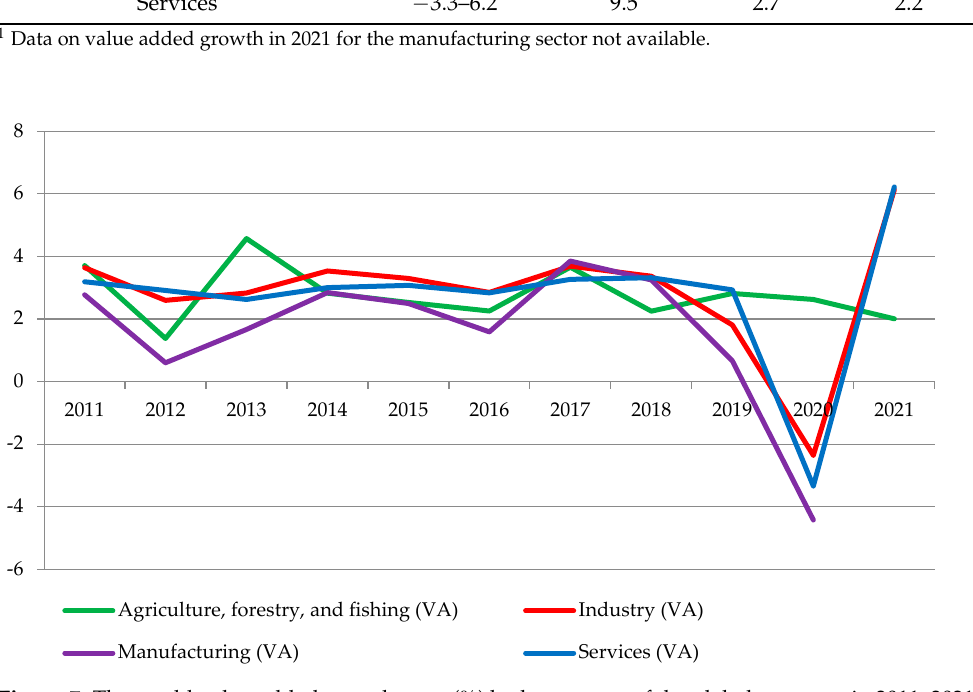
Figure 7. The world value added growth rates (%) by key sectors of the global economy in 2011– 2021.